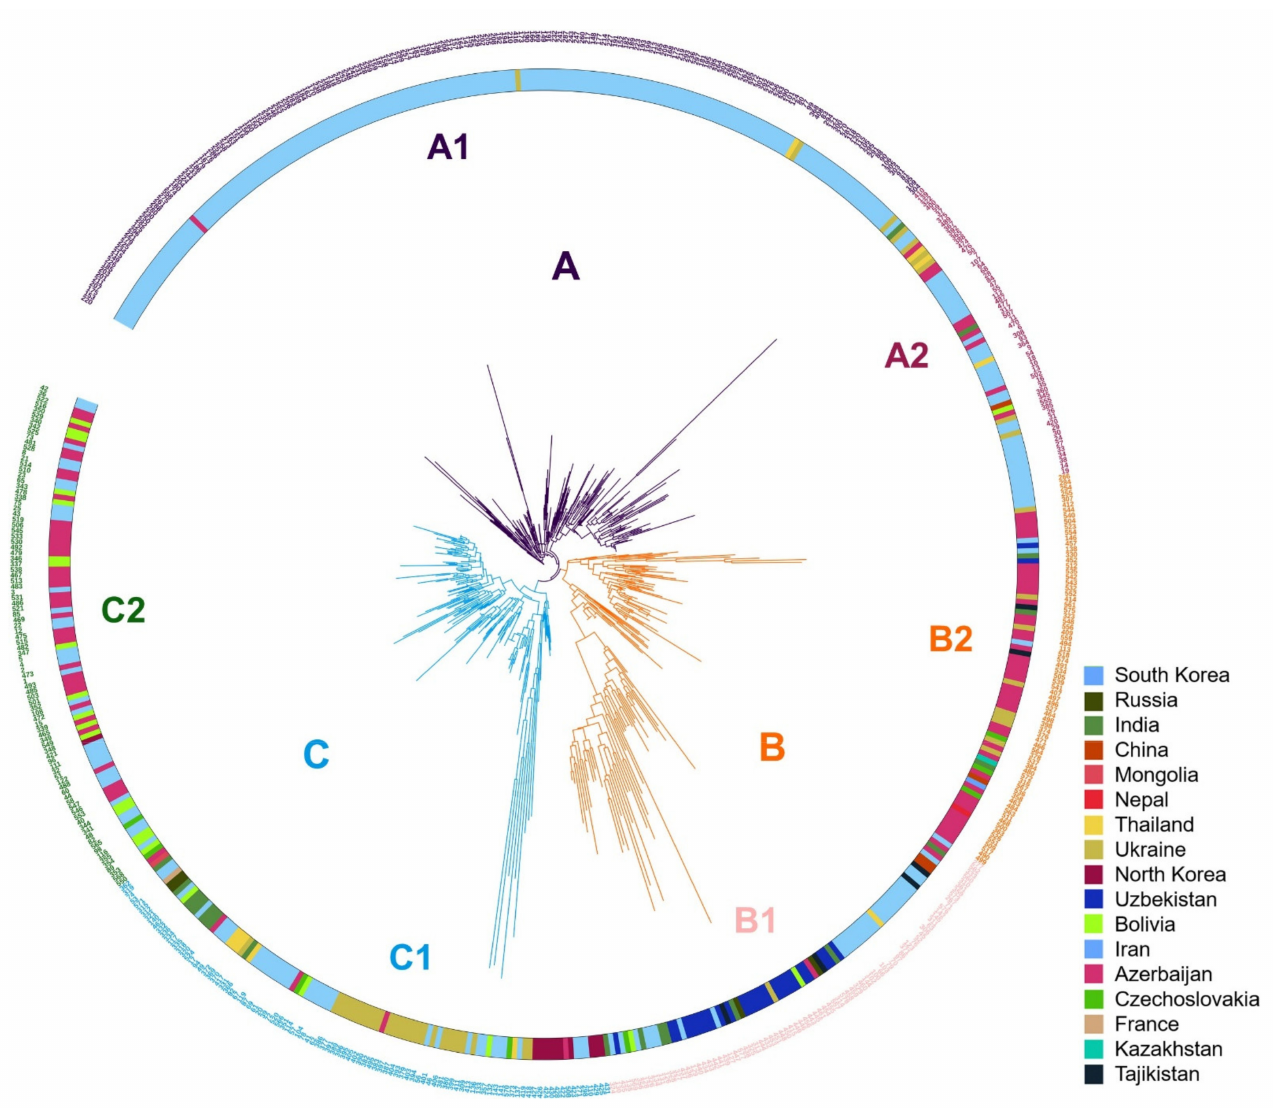
Figure 2. Phylogenetic tree for the three subgroups. Three clusters (A–C, indicated on branches) were identified, comprising a total of six subclusters with distinct geographical distributions and agronomic